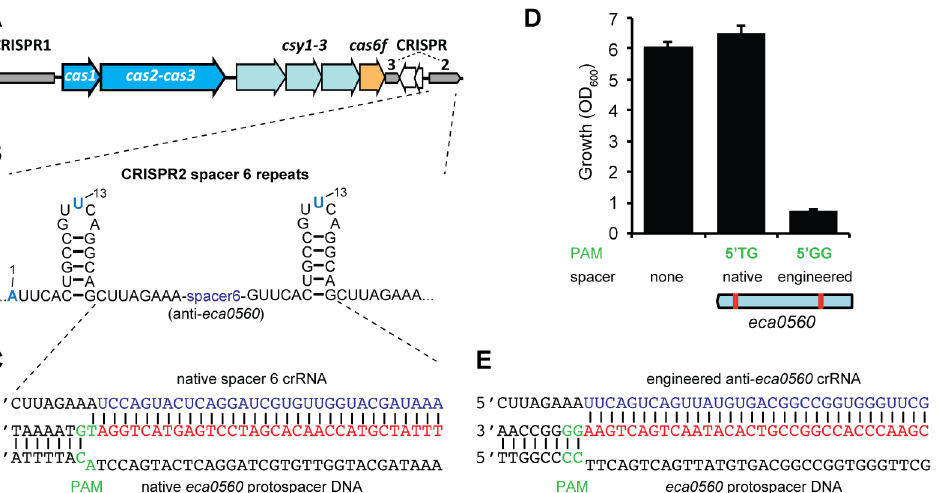
Figure 5. A single nucleotide PAM mutation enables escape from native CRISPR/Cas targeting. (A) P. atrosepticum CRISPR/Cas genomic organisation. The cas1 and the cas2 - cas3 hybrid genes are shown in blue, csy1 - 3 in pale blue, cas6f in orange and the CRISPRs as grey arrows in the direction of transcription. CRISPR2 and 3 are separated by a toxin/antitoxin system (white arrows). (B) Spacer 6 of CRISPR2 (from leader) contains deviations from the repeat consensus (shown in blue) and (C) has a 100% match to a protospacer (red) within eca0560 in HAI2 in the P. atrosepticum genome. The protospacer matching spacer 6 contains a non-consensus 5 9 -protospacer-TG-3 9 PAM (green). (D) Toxicity assays in the WT with plasmids containing consensus repeats and either no spacer (pC1-16), a single native spacer 6 (5 9 -protospacer-TG-3 9 PAM; pTraGS6-16) or an engineered spacer (5 9 -protospacer-GG-3 9 PAM; pTraG1-16) that targets eca0560 . The protospacer locations in eca0560 of the native (pTraGS6-16) and engineered (pTraG1-16) spacers are shown below in red. (E) Sequence and pairing of the engineered anti- eca0560 spacer (in pTraG1-16) with the consensus 5 9 - protospacer-GG-3 9 PAM (green).